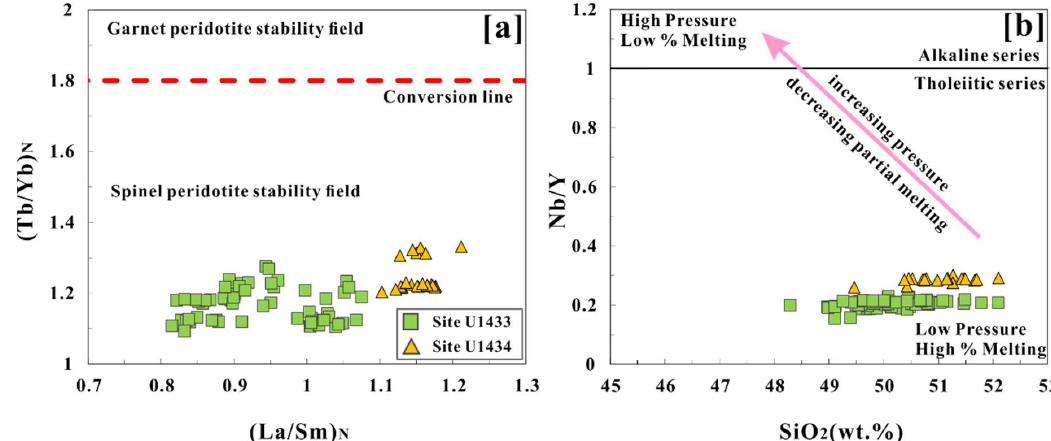
Figure 9. Diagrams of (Tb/Yb) N versus (La/Sm) N : ( a ) (after ref. [36]) and Nb/Y versus SiO 2 ; ( b ) (after ref. [35]) for basaltic samples at Sites U1433 and U1434. Red dashed line in (a) represents the conversion line, and it corresponds to a depth of 80 km.